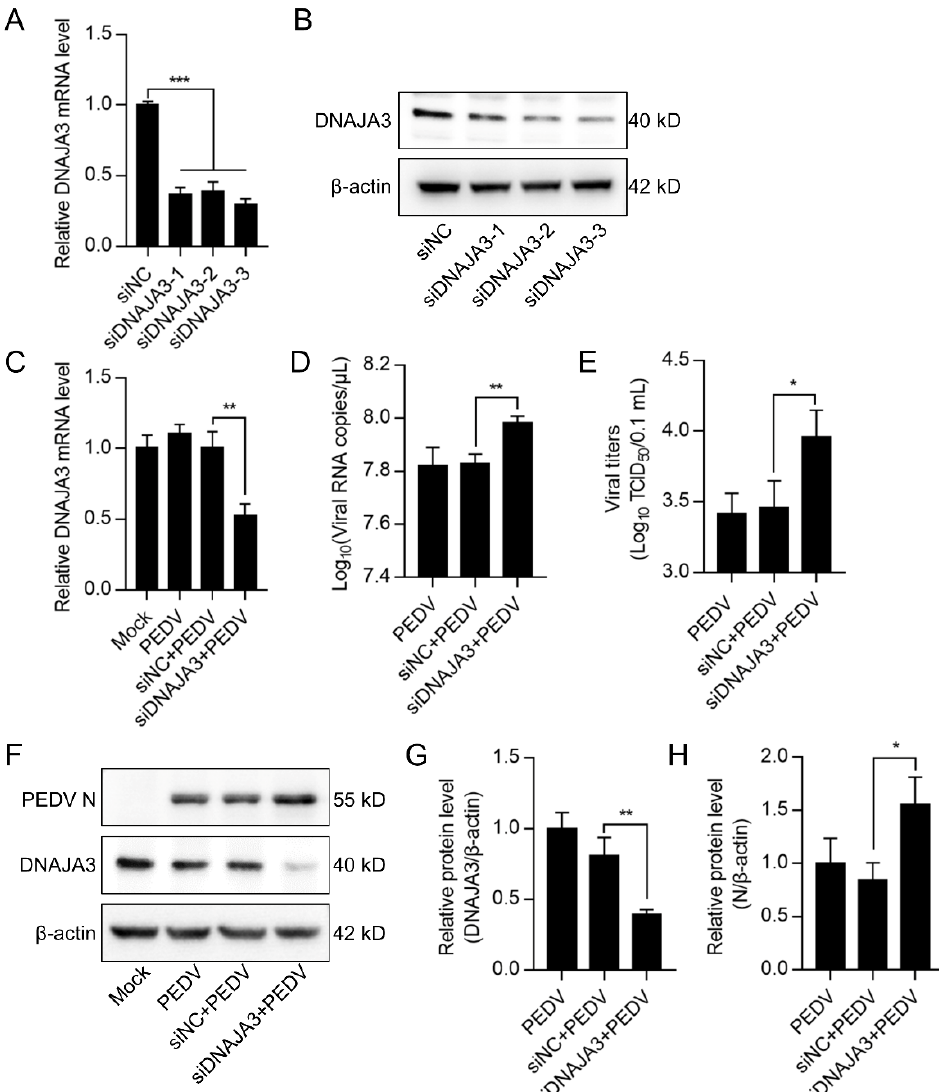
Figure 5. Knockdown of DNAJA3 facilitated PEDV replication. ( A , B ): IPEC-J2 cells were transfected with three interfering RNAs targeting DNAJA3 or with control vector (siNC) for 48 h. Downregu- lation of DNAJA3 by qPCR ( A ) and Western blotting ( B ). ( C – F ): IPEC-J2 cells were transfected with siDNAJA3-3 or siNC for 24 h and then infected with PEDV (MOI = 1) for additional 24 h for analysis of relative DNAJA3 transcription ( C ), viral RNA copy numbers ( D ), viral titers (TCID50)( E ), and levels of PEDV N and DNAJA3 ( F ) in the infected cells. ( G , H ): Ratios of DNAJA3 ( G ) or N protein ( H ) to β -actin of panel F. All results are presented as the mean ± SD of data from three independent experiments. *, p < 0.05; **, p < 0.01; ***, p < 0.001.